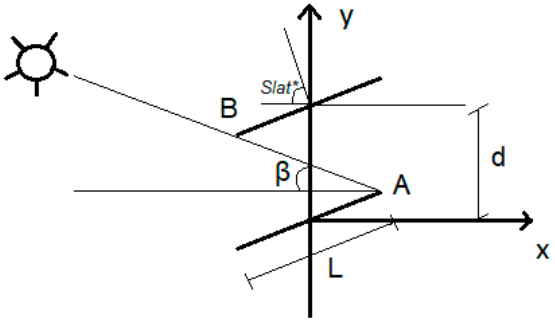
Figure 3. Limit inclination for direct radiation blocking.